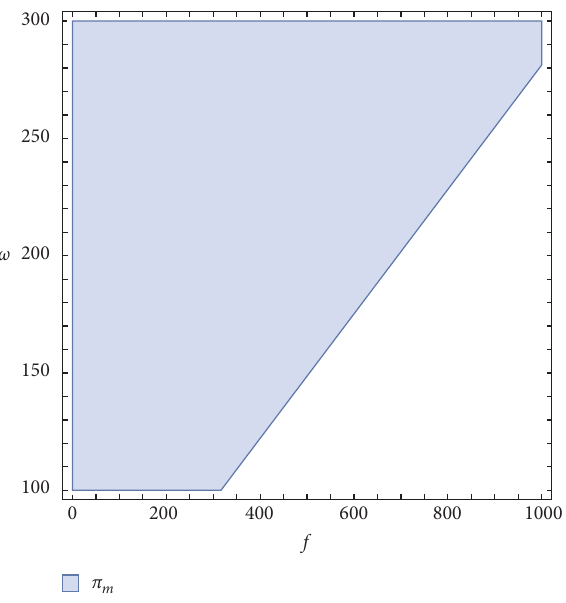
Figure 10: The interval of f and ω where the manufacturer can make better